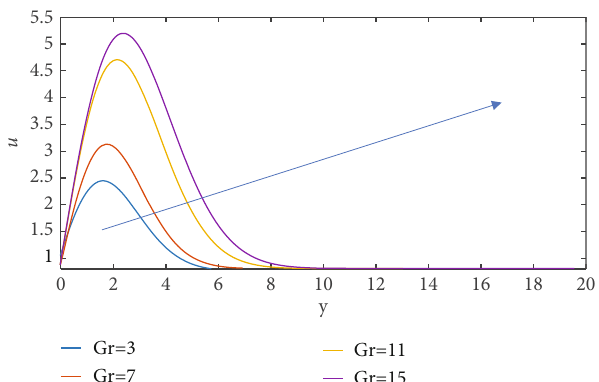
Figure 11: Increasing values of Gr for velocity fi eld when ⋋ = 1 , M = 2 , Kc = 1 : 5 , k = 1 , F = 1 , Gc = 5 , Sc = 2 : 01 , Pr = 6 : 2 , Ec = 0 : 1 , m = 1 , H = 2 , and t = 1 .